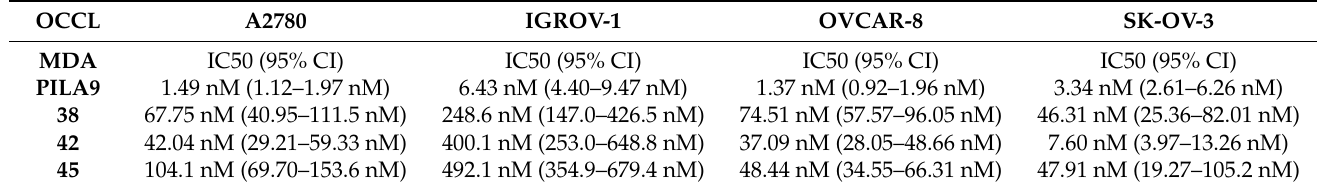
Table 1. IC50 values for MDA. Best-fit values for IC50 values and interval in which IC50 is included. These values were calculated using GraphPad Prism software (version